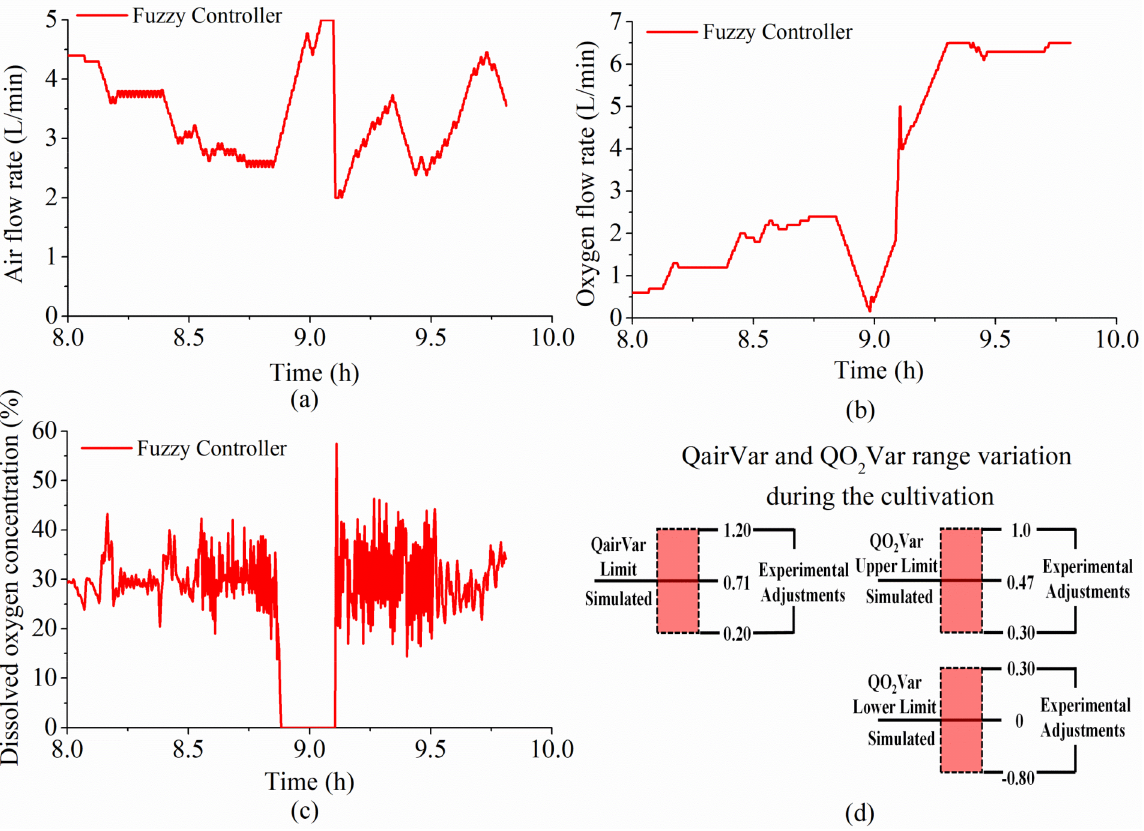
Figure 8. Initial E. coli cultivation tests results. Fuzzy controller was activated for almost two h during the cultivation. Dynamics of air ( a ) and oxygen ( b ) flow rates, dissolved oxygen behavior ( c ), and experimental adjustment in limits for QairVar and QO 2 Var ( d ) during the E. coli cultivation